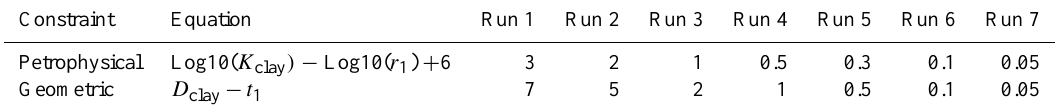
Table 2. Coupling constraints standard deviations, e c , used for JHI Runs